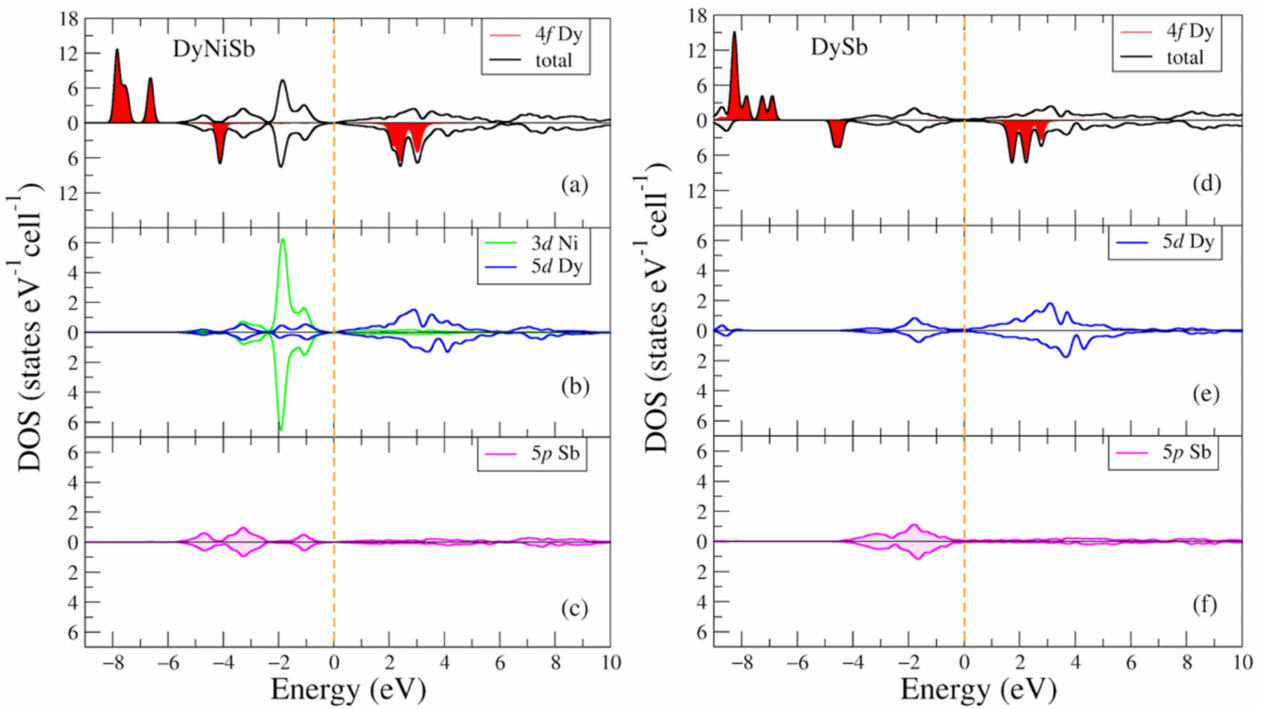
Figure 5. Densities of electronic states from DFT+U for ( a – c ) DyNiSb; ( d – f ) DySb. ( a , d ) Total and partial Dy-4f densities of states; ( b , e ) partial density of states for Dy-5d (Ni-3d); ( c , f ) partial density of states for Sb-5p. The plot is shifted relatively to the Fermi energy shown at zero as a vertical dashed